Question: Generate an informative caption for the figure above.
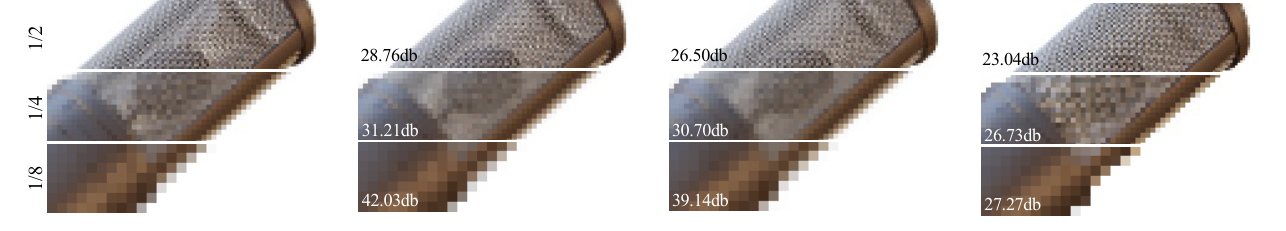
Answer: Qualitative comparison of the multi-resolution evaluation on the mic scene from the multi-scale Blender dataset. PSNR values are shown in the bottom right corners of each result.